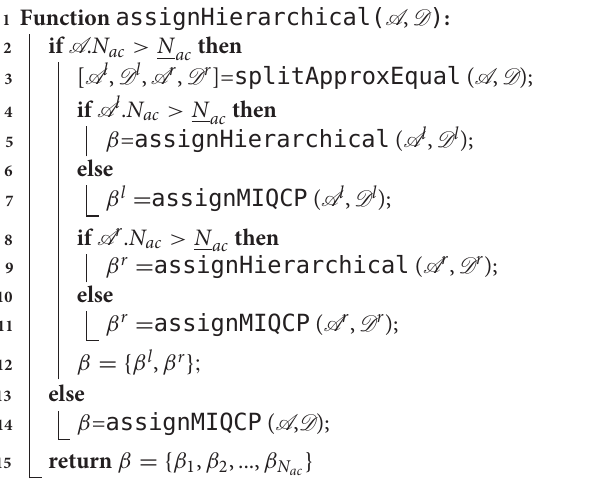
Algorithm 1: Defender-Swarm